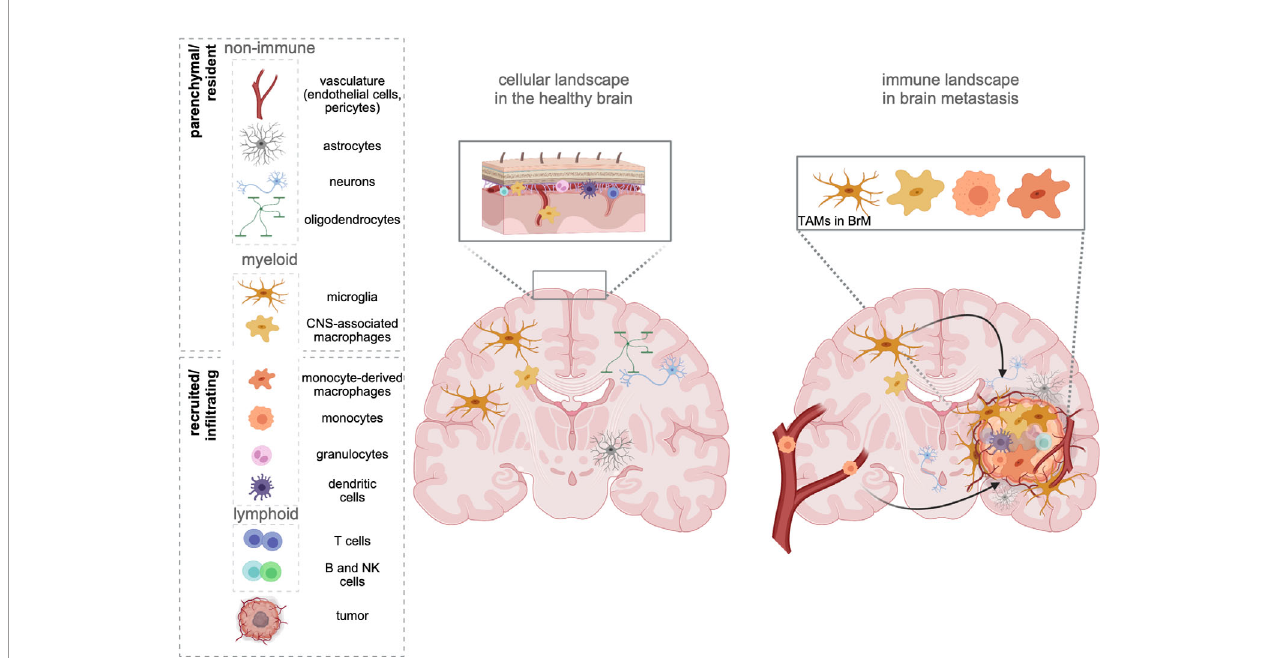
FIGURE 1 | The cellular environment in the healthy brain and BrM. The healthy brain parenchyma consists of resident cell types, including neurons, astrocytes, oligodendrocytes, and cells forming the vasculature (endothelial cells, pericytes). While microglia represent the sole immune cells within the parenchyma, border- associated areas of the brain (e.g., meninges, perivascular areas) harbor every other cell type of the immune system. In contrast, brain metastasis (right) induce the recruitment of all types of myeloid and lymphoid immune cells from the periphery. Tumor-associated macrophages (TAMs) represent a heterogeneous pool of myeloid cells, which consist of brain-resident microglia, as well as monocytes, and monocyte-derived macrophages from the periphery. Recent studies further suggest a partial involvement of recruited CNS/border-associated macrophages